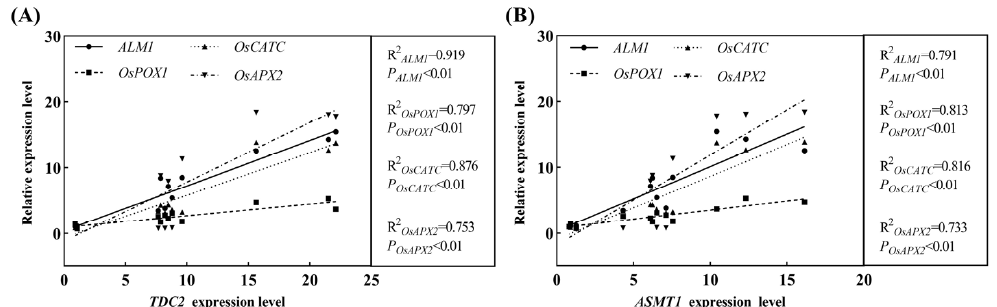
Figure 9. Correlation analysis of melatonin synthesis-related genes and antioxidant enzyme synthesis genes under drought stress. ( A ) Correlation of TDC2 and antioxidant enzyme synthesis genes. ( B ) Correlation of ASMT1 and antioxidant enzyme synthesis genes.